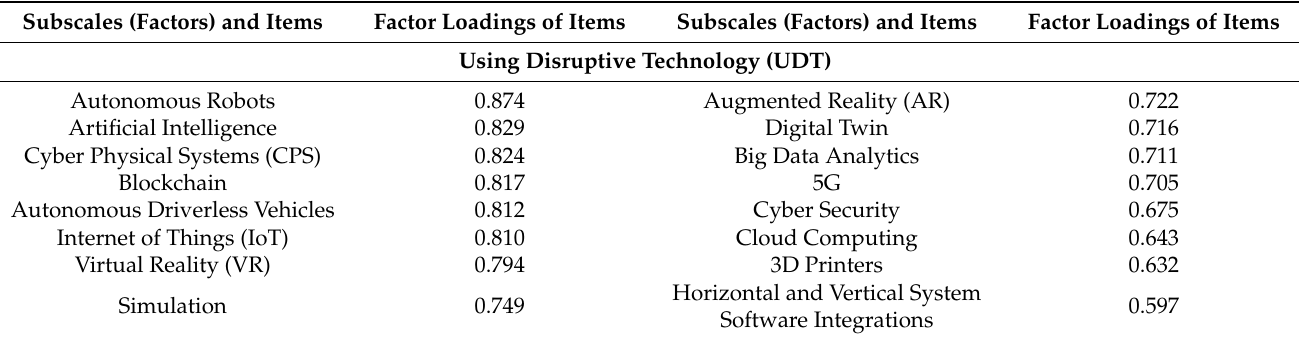
Table 4. Factor Loadings for Pilot